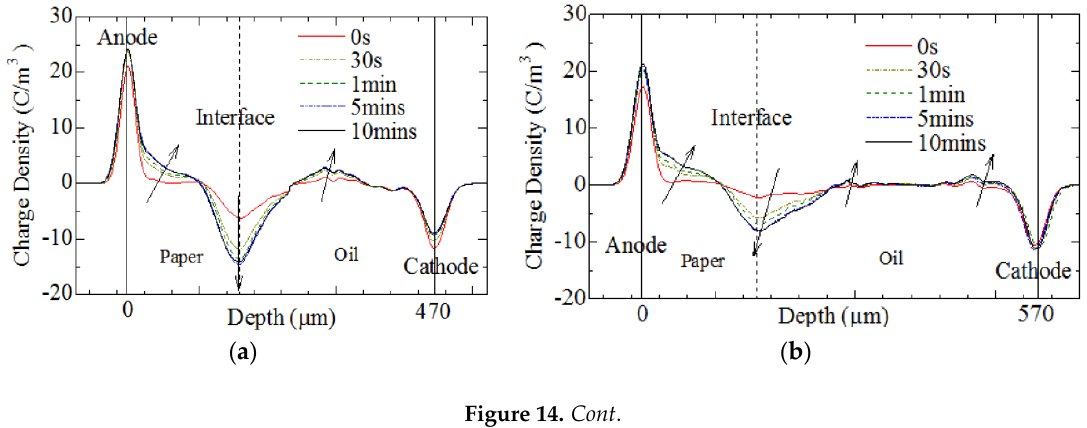
Figure 14. Cont. Figure 14. Cont.